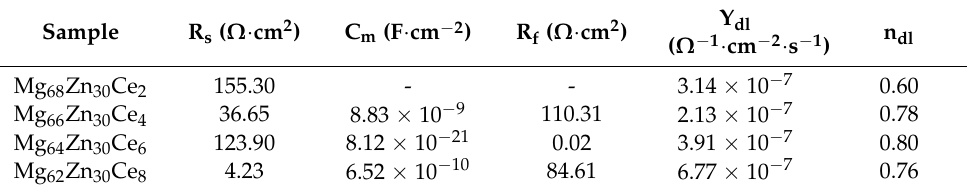
Table 3. The second part fitting results for each component in the equivalent circuit